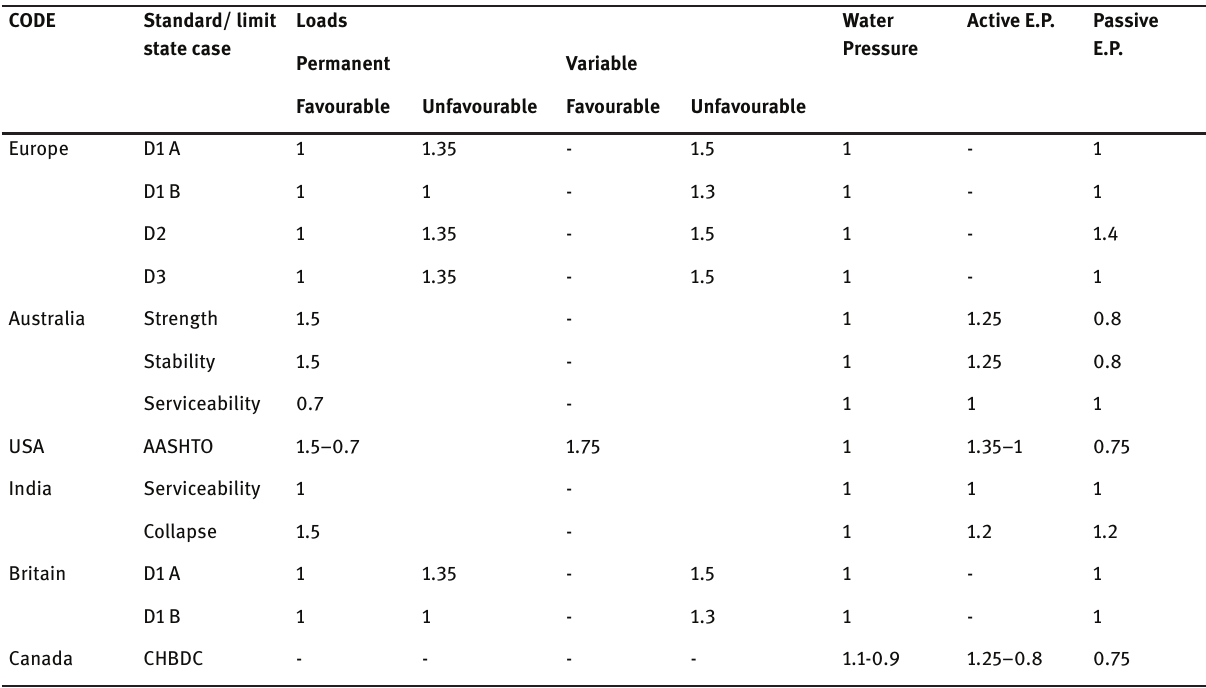
Table 1: Partial factors of safety applied on loads.